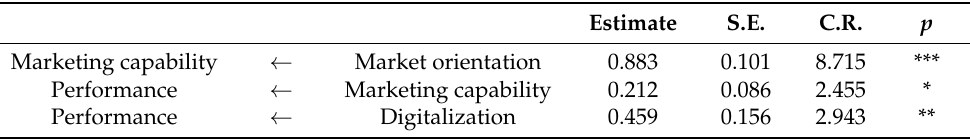
Table 4. Estimated values, standard errors (S.E.) critical ratios (C.R.) and probability values (P) for the path model (firms operating in their domestic markets).